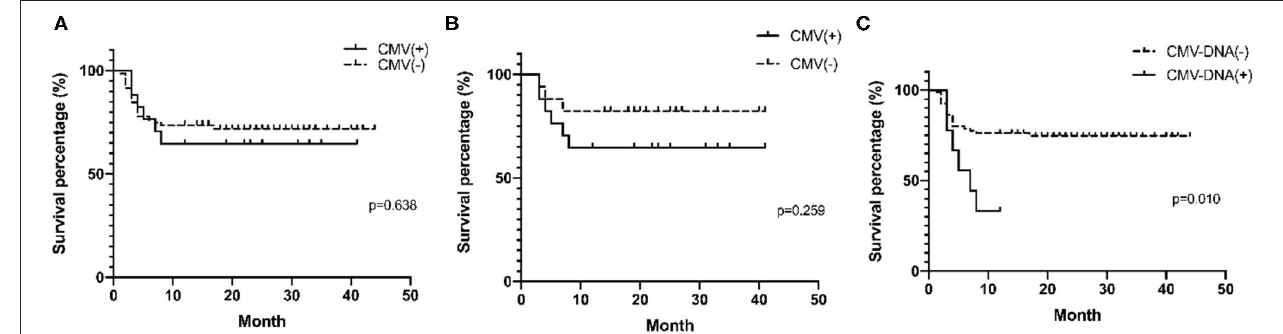
FIGURE 3 | Survival analysis of MDA5 + DM patients with CMV infection by Kaplan–Meier curve. (A) Survival percentages stratified to recent CMV infection (CMV-IgM positive and/or CMV DMA-emia) in all MDA5 + DM patients ( p = 0.638). (B) Survival percentages stratified to recent CMV infection (CMV-IgM positive and/or CMV